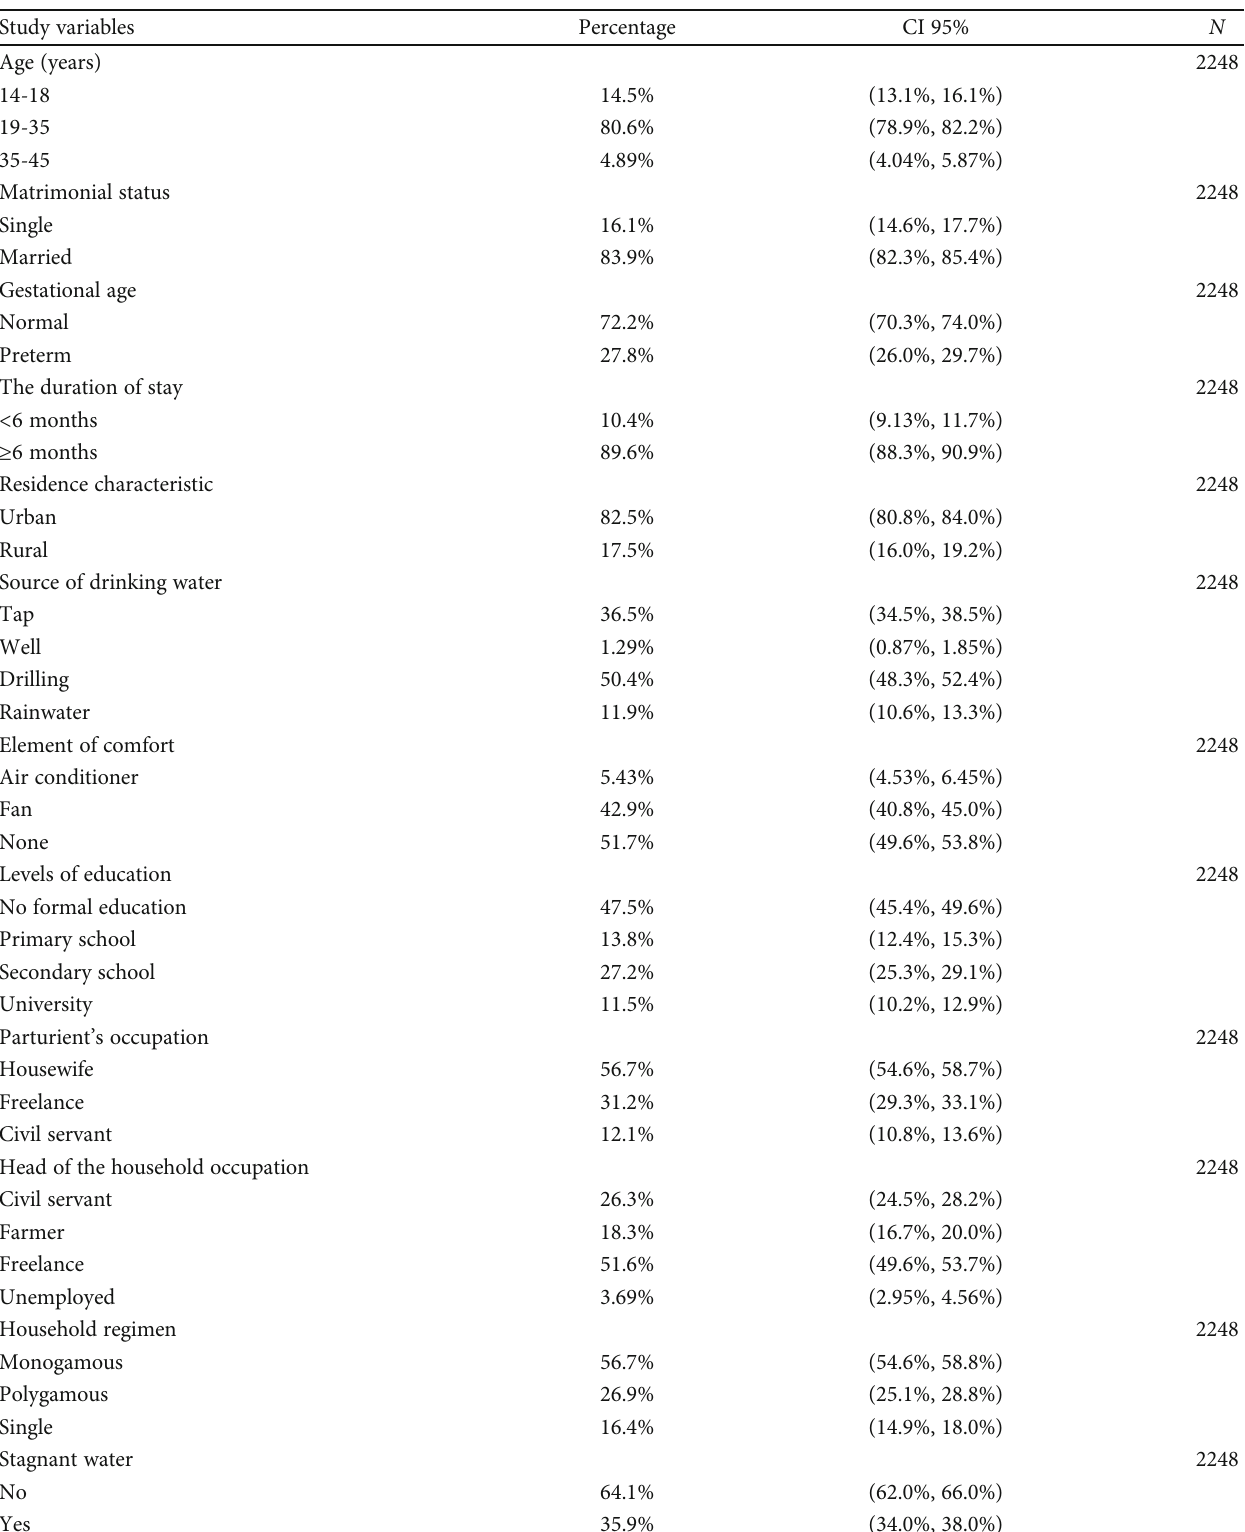
Table 1: Description of the